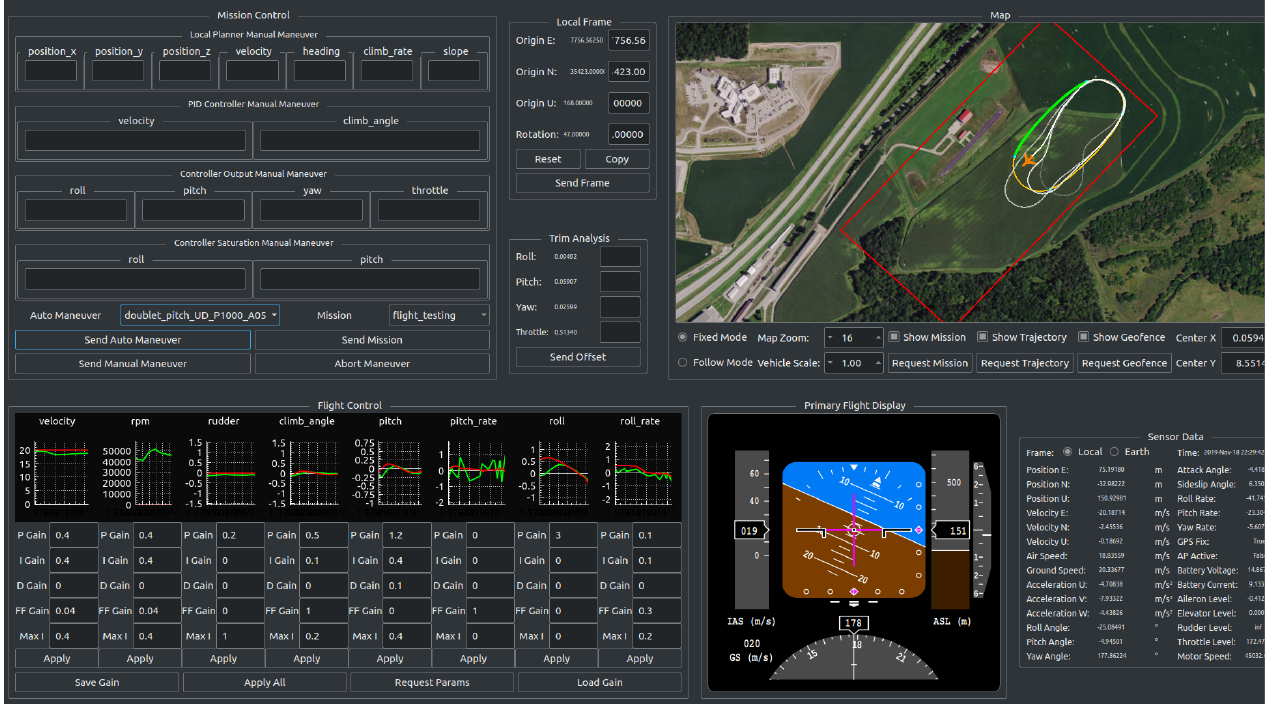
Figure 11. The uavEE ground station interface, which provides functionality in emulation and real flight; it is shown being used to automate a pitch doublet maneuver as part of the flight testing automation